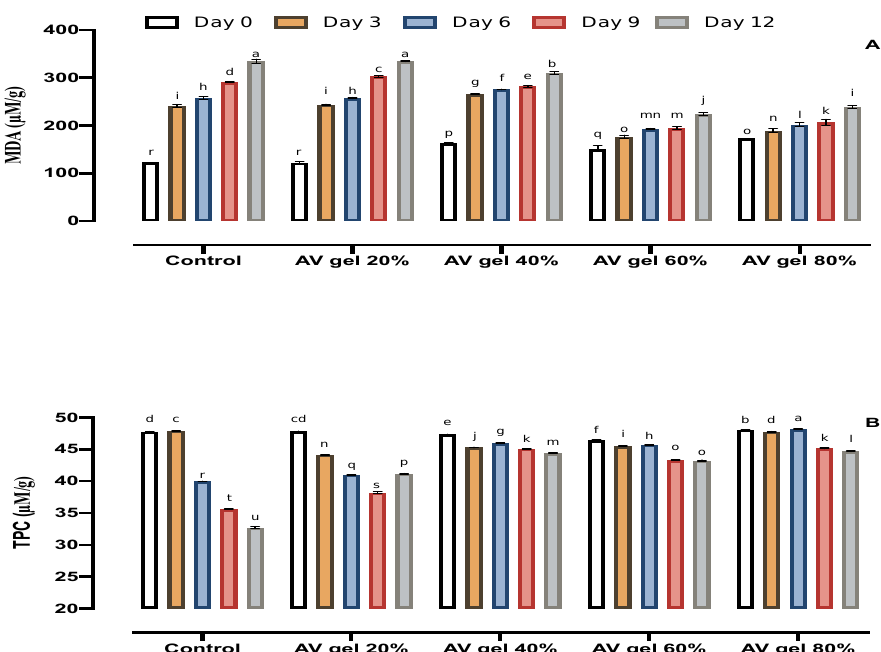
Figure 4. Effects of AV gel coating on malondialdehyde (MDA) production ( A ) and total phenolics compounds (TPC) content ( B ) in guava fruit. Standard error showed by vertical bars and each value is mean of three replicates. Different letters on the top of bars indicate significant differences at p ≤ 0.05.